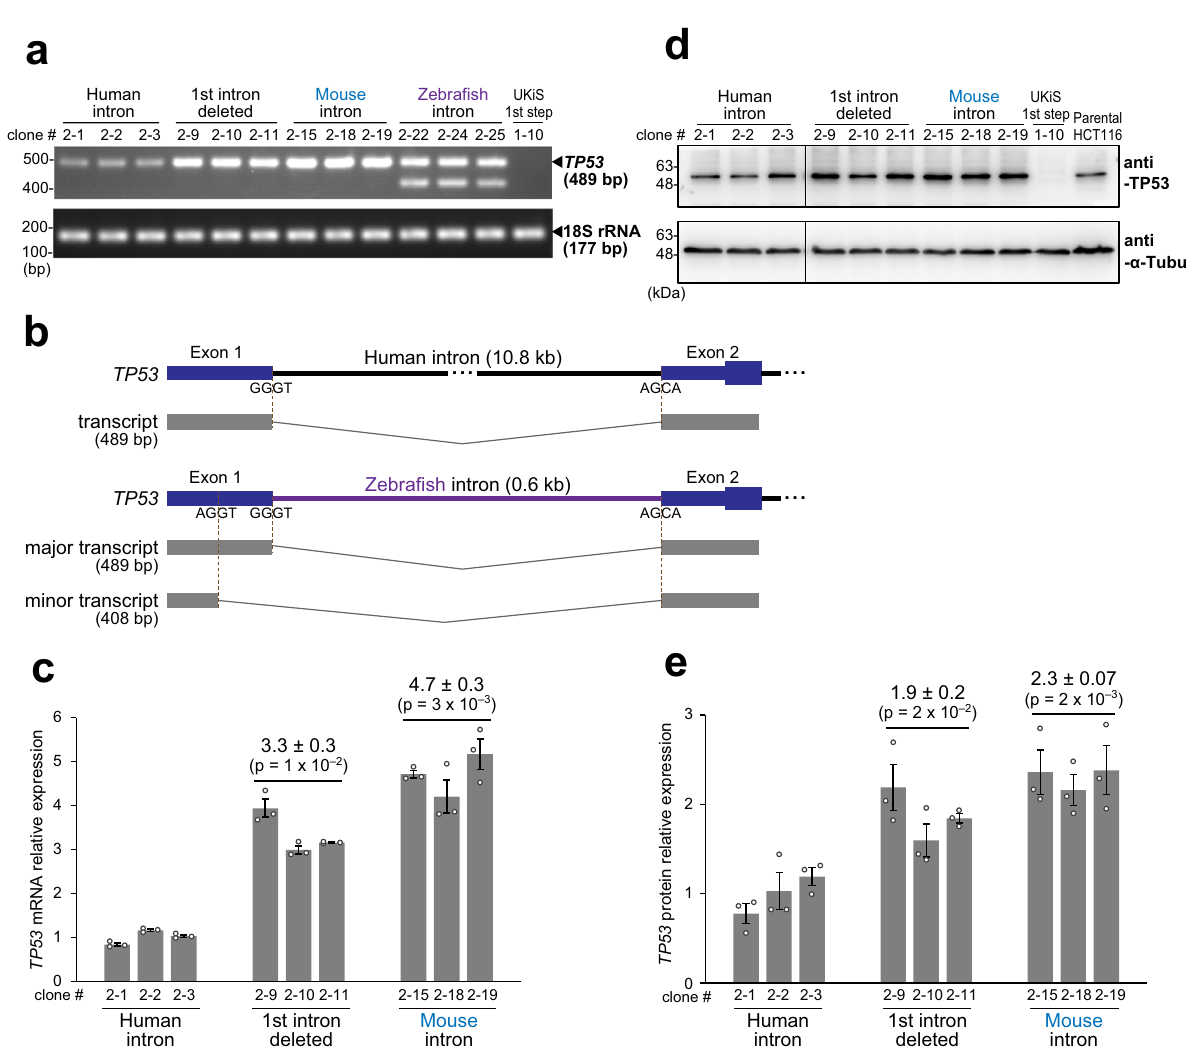
Fig. 5 Evaluating the in fl uence of intron deletion and syntenic substitution of the fi rst intron of TP53 on its expression. a Representative image of agarose gel electrophoresis for RT-PCR products targeting the TP53 mRNA from three clones of the four variants of the fi rst intron of TP53 : human wild- type intron, intron deletion, mouse intron, and zebra fi sh intron (clone numbering in this fi gure is as in Figs. 3 and 4). b Schematic drawing of splice site selection of the TP53 fi rst intron in the cell clones with the wild-type human intron (top) and the zebra fi sh intron (bottom). In the HCT116 cells,